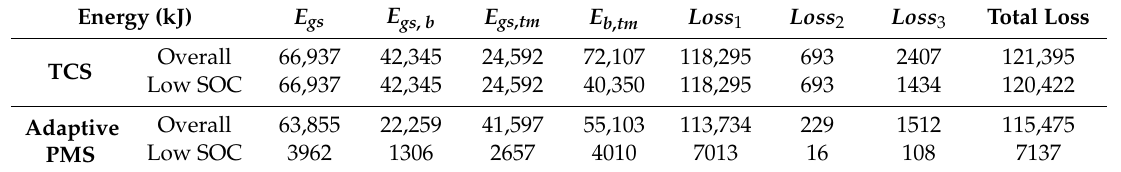
Table 8. Energy usage comparison of TCS and adaptive PMS for 6 FTP.